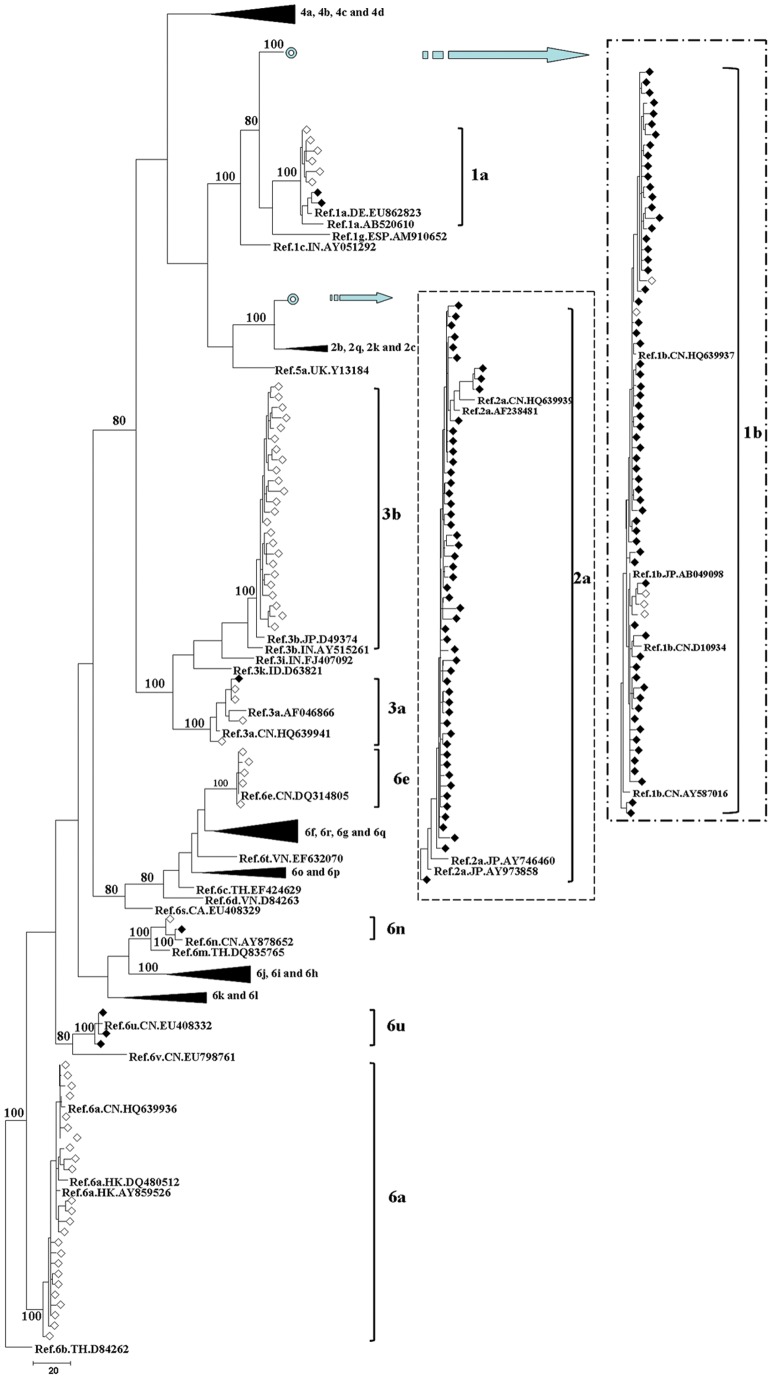
MPT for the HCV NS5B region sequence obtained from HIV/HCV co-infected patients in Henan and Guangxi.The sequences correspond to nucleotides 8,343-9,226 in HCV H77 genome (NC_004102). This dataset included sequences from 242 HCV specimens. The dataset had an aligned length of 884 characters in the dataset, of which, 318 characters are constant, 45 are variable and parsimony-uninformative, and 521 are parsimony-informative. Maximum Parsimony analysis yielded 88 equally parsimonious trees (TL  = 2073, CI  = 0.314, RI  = 0.774, RC  = 0.287, HI  = 0.686). Parsimony bootstrap proportions higher than 70% were indicated along branches. The sequences determined in this study are indicated by the following signs: sequences from Henan (♦), sequences from Guangxi (◊). Reference sequences used to classify HCV genotypes are displayed in bold with the following format: Ref/subtype/country code/accession number.